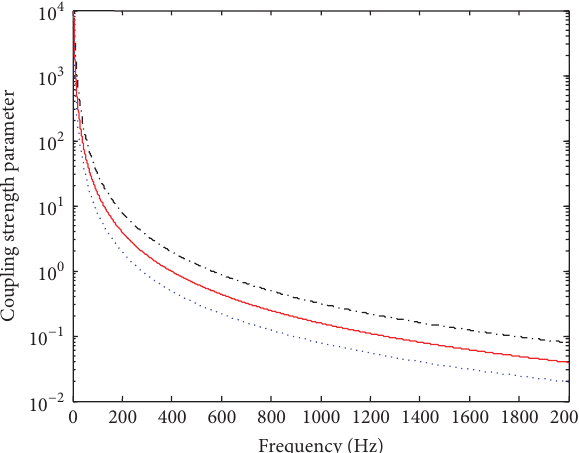
Figure 4: Coupling strength parameter 𝛾 2 between two coupled plates: 𝑁 = 1 (dotted line); 𝑁 = 2 (real line); 𝑁 = 4 (dash-dotted line).